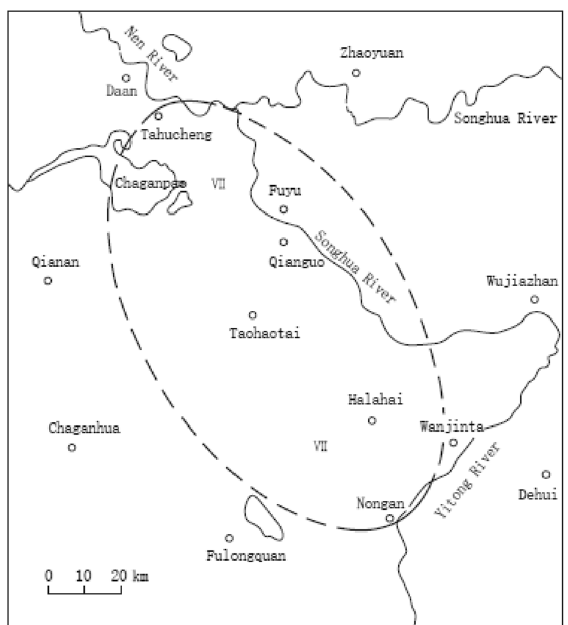
Figure 1. Isoseismal map of Qianguo earthquake occurring on 1119 at the surrounding region of Songyuan city. Adapted from Wu et al. We created this figure in using ArcGIS 10.0 (URL: http:// www. esri.